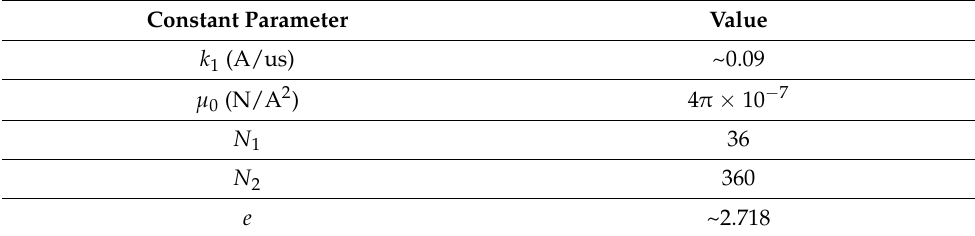
Table 1. The constant parameters used in this